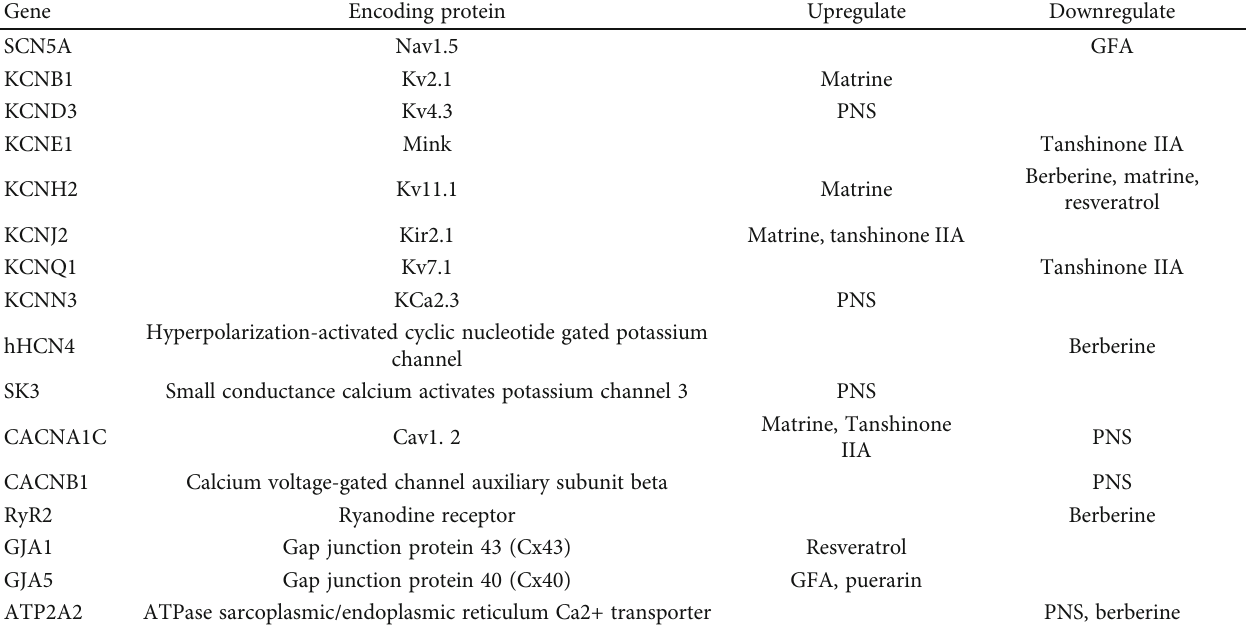
Table 2: Natural product active components ’ regulatory e ff ects on the genes responsible for ion channel